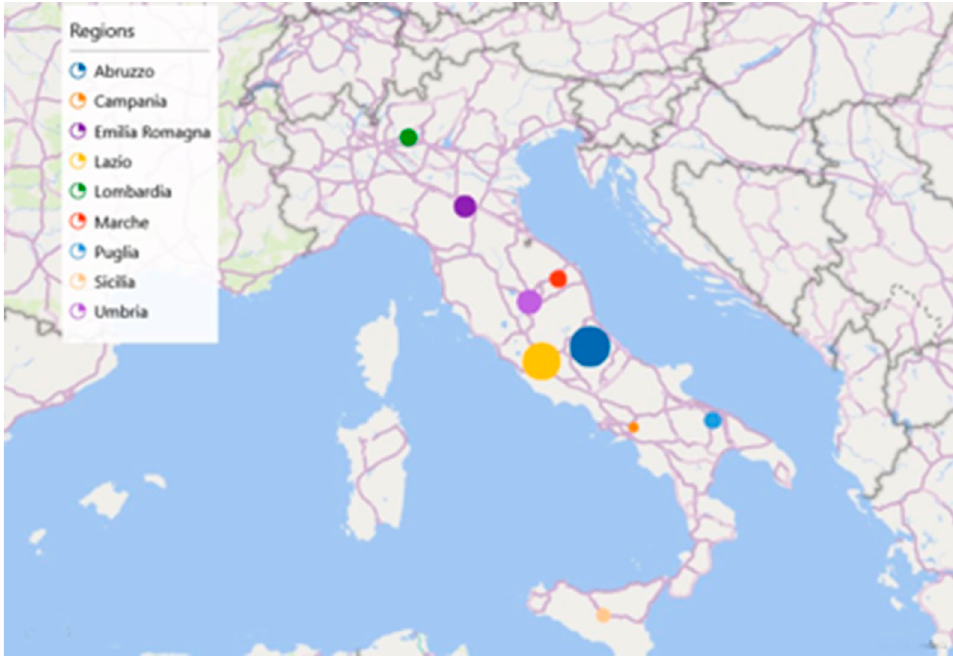
Figure 1. Graphical representation of the distribution of the 54 cases of DTD in Italy.